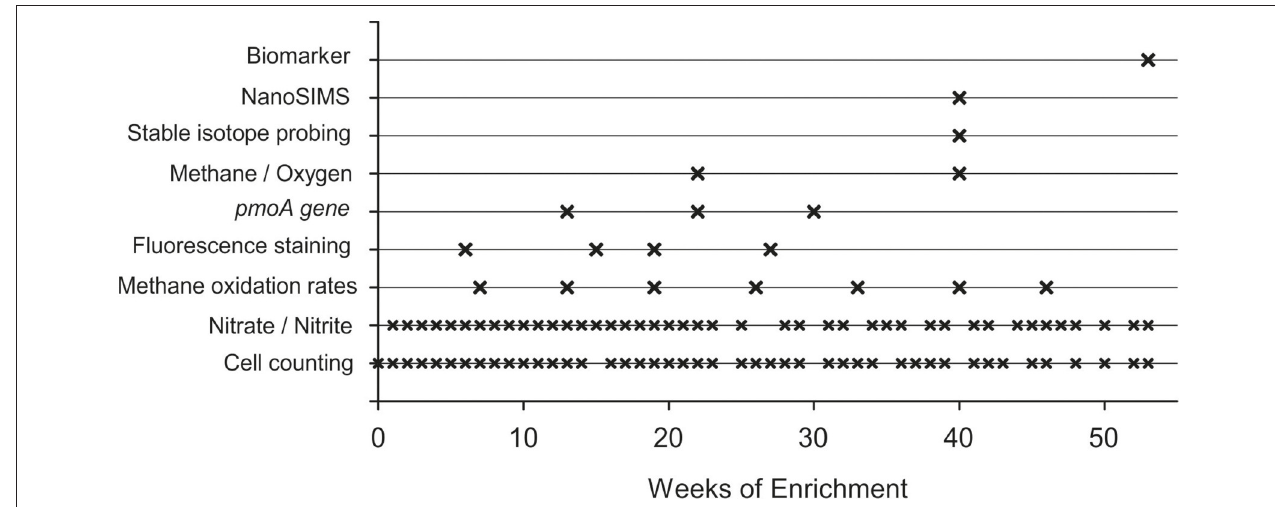
FIGURE 3 | Chronological overview of the analyses during the enrichment experiment.